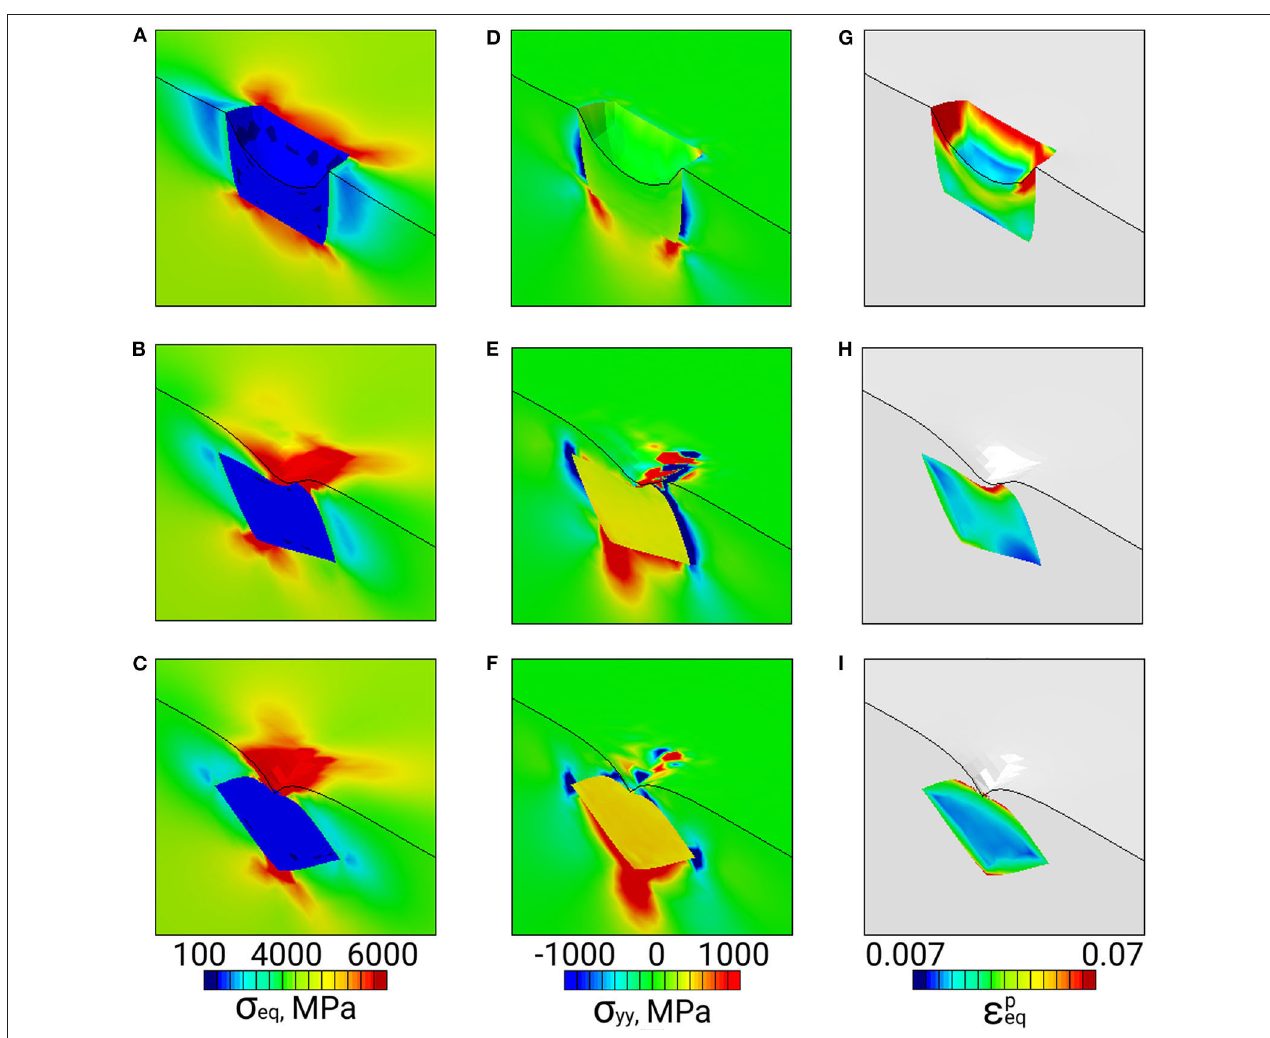
FIGURE 4 | Von Mises stress (A–C) , normal stress σ yy (D–F) , and equivalent plastic strain fields (G–I) in the vicinity of a soft inclusion positioned in an elastic matrix near the surface (dash-bordered regions in Figures 1A–C ).